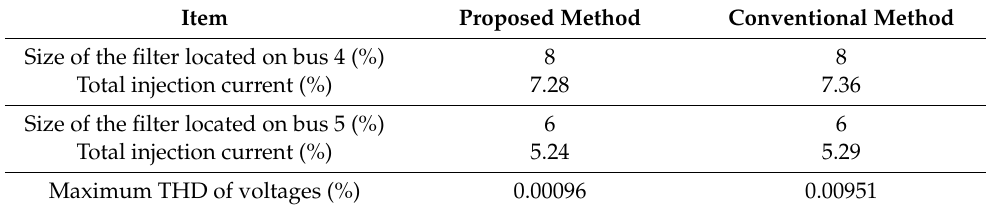
Table 9. Results of allocation of filters in 9-bus test